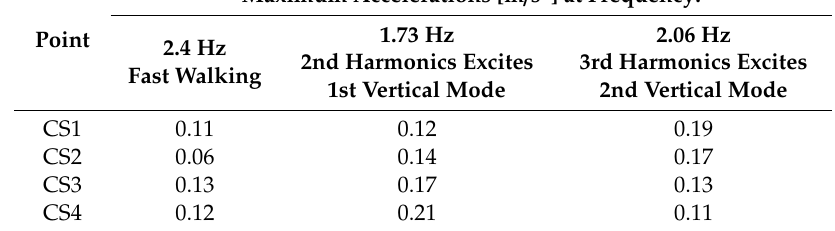
Table 8. Maximum vertical accelerations generated by a single pedestrian walking obtained at the representative points of the cable-stayed footbridge with the GFRP slab for the selected frequencies.